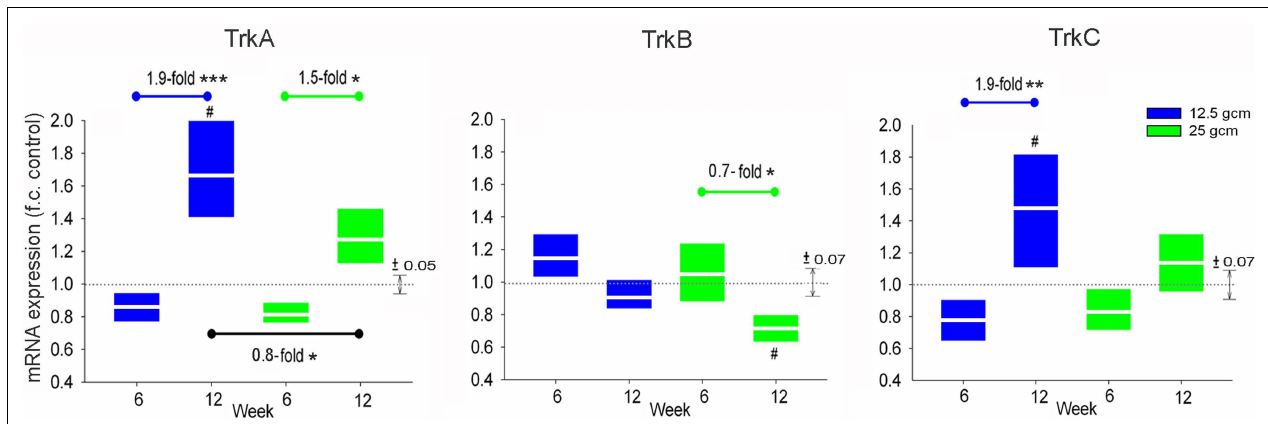
12.5gcm at 12weeks. X axis denotes weeks post injury.White lines in box-plots indicate group mean. Dotted gray lines indicate expression level of controls (normalized to 1), with ± SEM indicated by the vertical arrows at right end of the control line. # p < 0.05 vs. control, * p < 0.05, ** p < 0.01, *** p < 0.001.